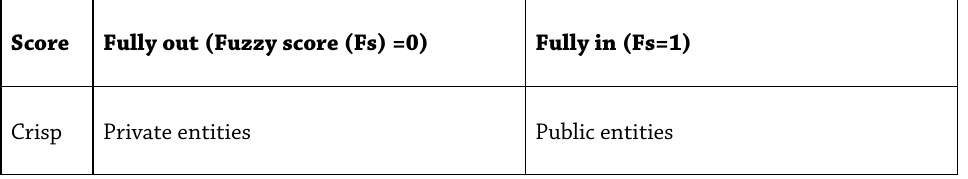
The company is experiencing significant external pressure, which require organisa- tional attention beyond daily operations. This for example includes take-overs, larger organisational changes, loss of huge market shares or major clients and signifi- cant/extraordinary budget restraints.